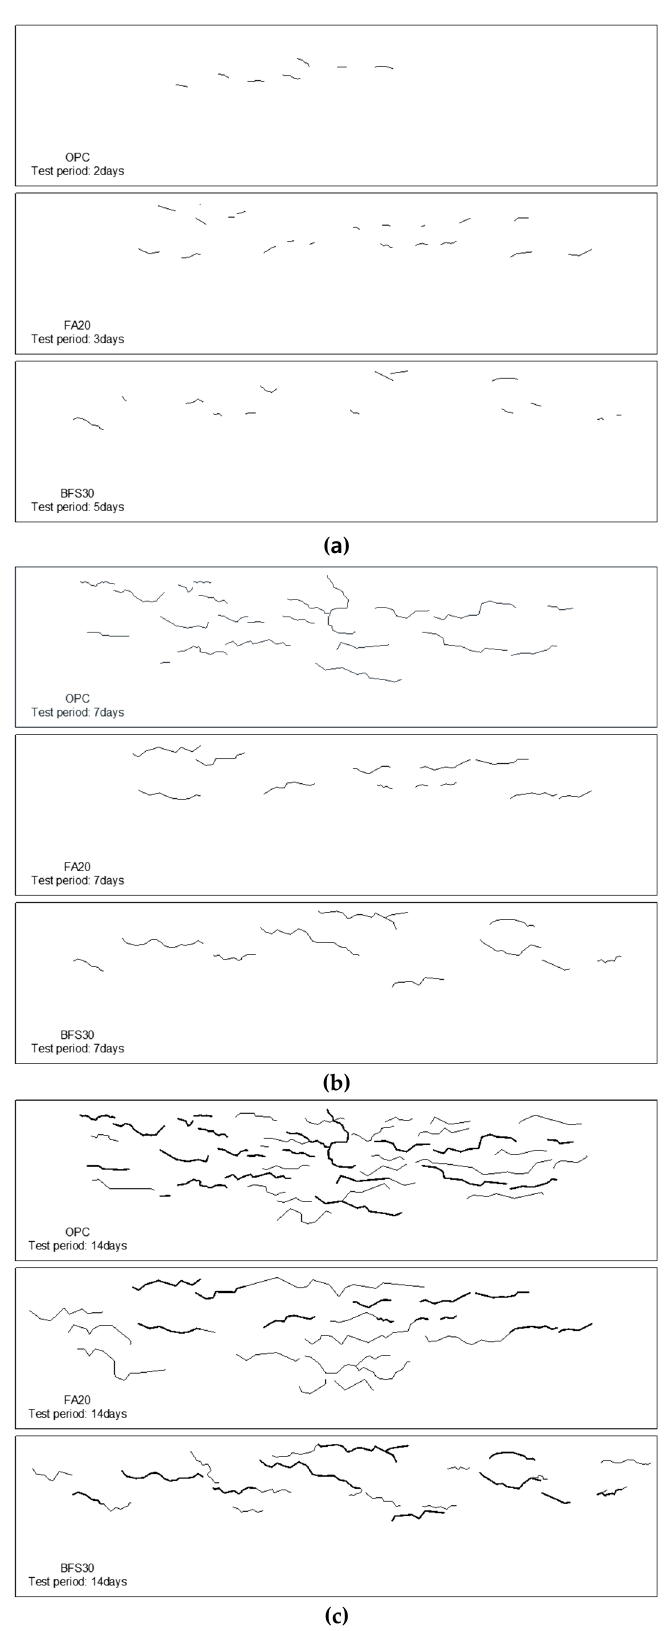
Figure 5. Crack progression patterns of concrete specimen. ( a ) Test period: crack initiation; ( b ) Test period: 7 days; ( c ) Test period: 14 days.